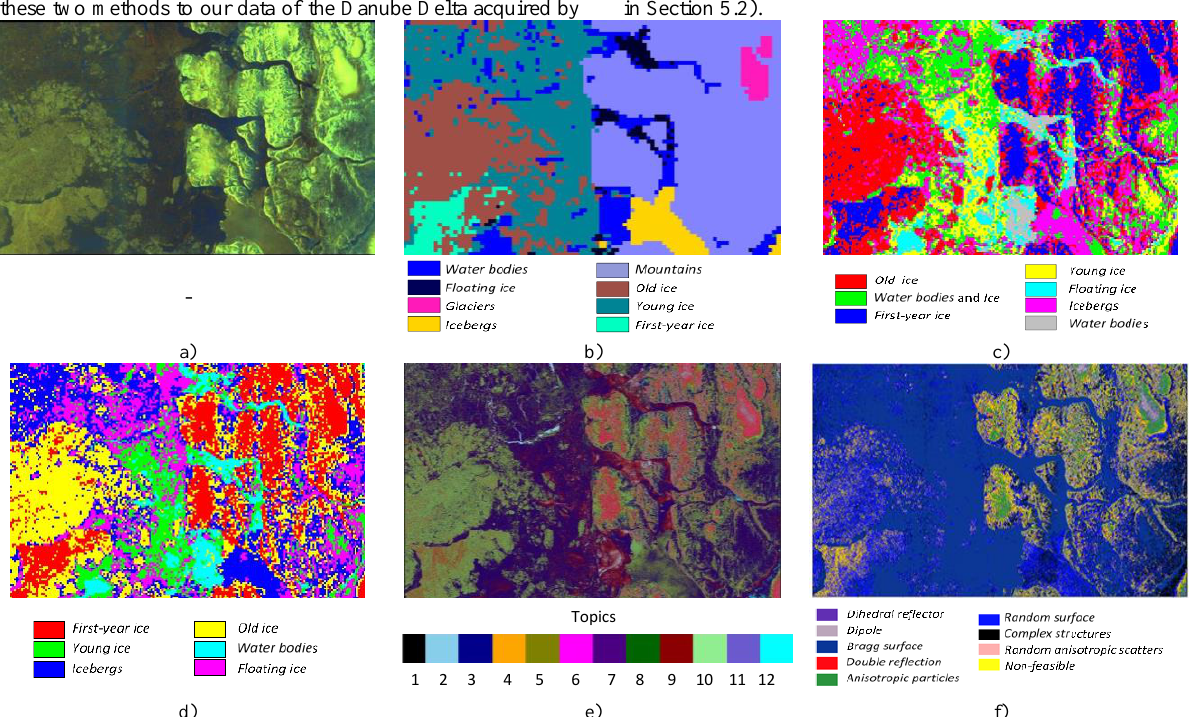
Figure 2 . An image example of Belgica Bank, Greenland acquired on April 17 th , 2018. (From left to right, upper part): The Sentinel- 1 quick-look image, our semantic classification based on active learning (with Gabor filtering as feature vector and an SVM as classifier), our semantic classification based on compression (with dictionaries as feature vector and k -means as classifier); (From left to right, lower part): Our semantic classification based on compression (with dictionaries as feature vector and a GMM as classifier), the topic representation based on LDA, and the physical scattering representation based on a hybrid approach (LDA and CNNs). Each case includes a colour legend, except figure a) which is the quick-look of the analysed